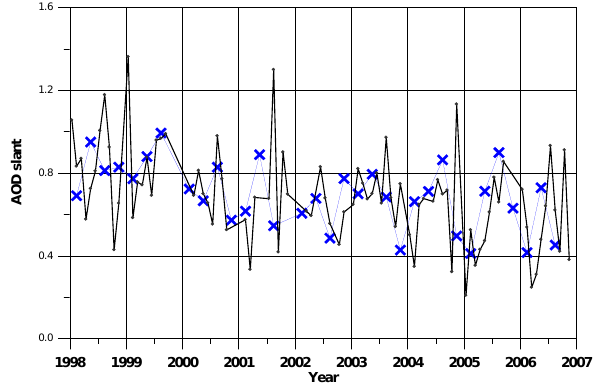
Fig. 4. Seasonal (black dots) and monthly (blue dots) RFE% Figure 4. Seasonal (black dots) and monthly (blue dots) RFE% changes calculated for changes calculated for Thessaloniki area over the period 1998– Thessaloniki area. 2007. Magenta points represent SSA calculations and their uncer- tainty